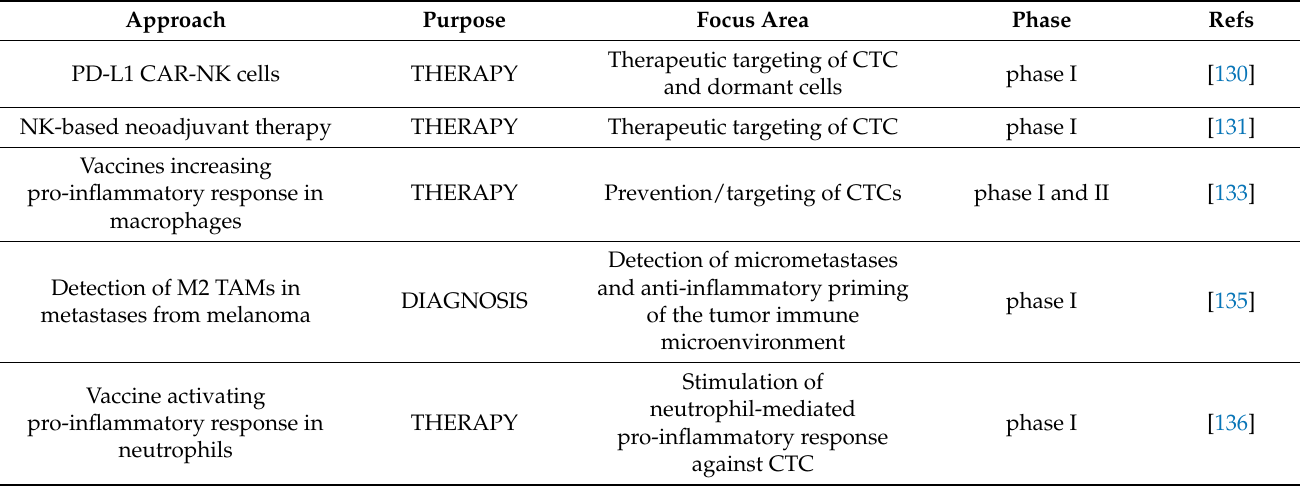
Table 1. Summary of the clinical trials and pre-clinical studies focusing on the innate immune system for therapeutic and diagnostic purposes currently under investigation in the context of metastatic